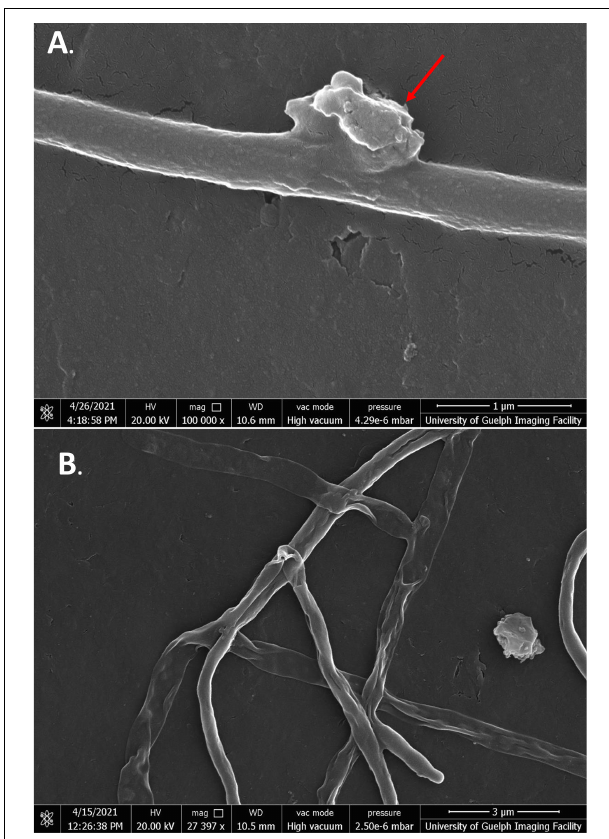
FIGURE 8 | SEM images of S. scabies grown in the presence of jaceosidin. (A) S. scabies grown overnight in nutrient broth with 4% DMSO and jaceosidin at 1/2 MIC concentration with a metal spring for shearing shown at 100,000 times magnification. (B) S. scabies grown as in A except with jaceosidin at MIC concentration shown at 82,747 times magnification. The two red arrows point to holes in the outer membrane. Images were taken via a Quanta 250 FEG SEM (FEI company, OR, United